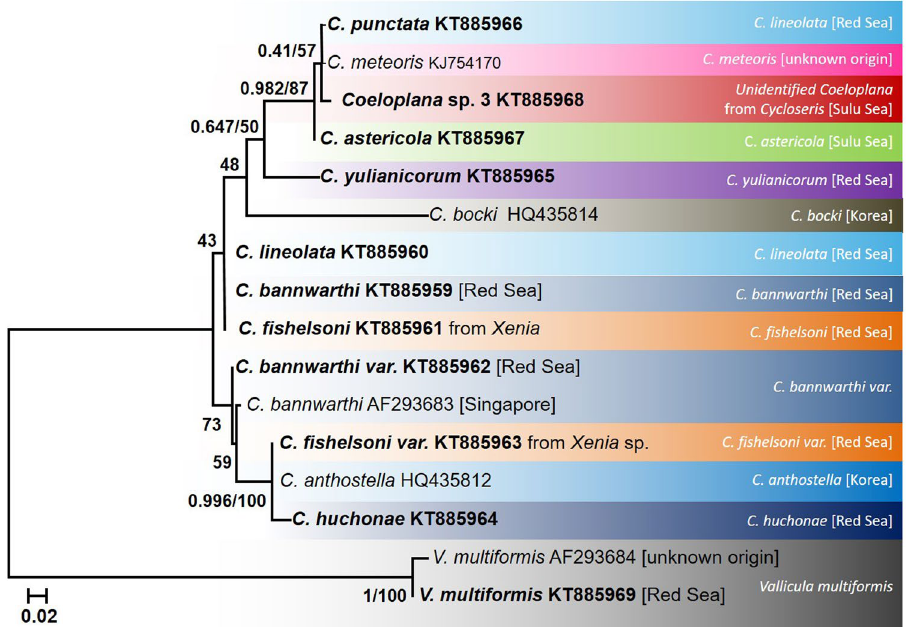
Figure 3. ITS1 maximum likelihood tree. The phylogenetic reconstruction was based on 397 bp from the ITS1 marker. ML bootstrap support/Bayesian posterior probabilities are indicated near the corresponding nodes. Sequences generated in the framework of this study are highlighted in bold. Coeloplanidae species considered valid based on the COI analysis, are indicated by different colors.